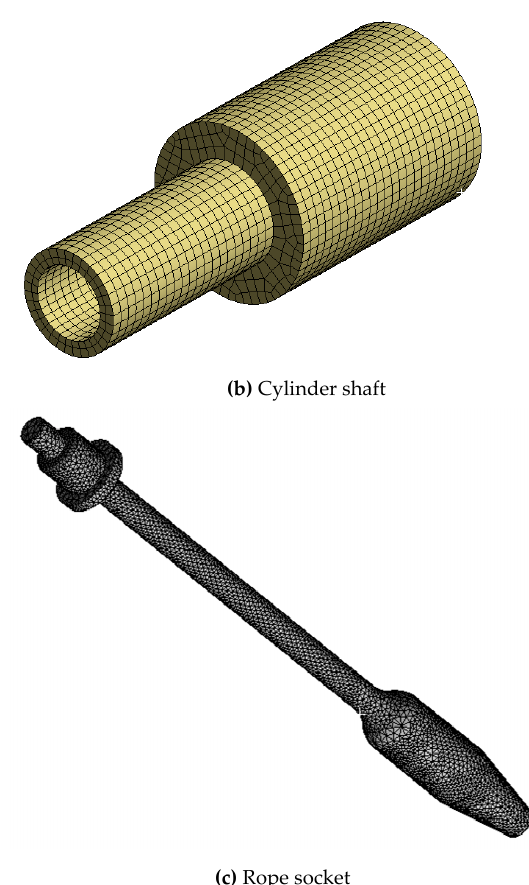
Figure 5. Meshing of the important components.